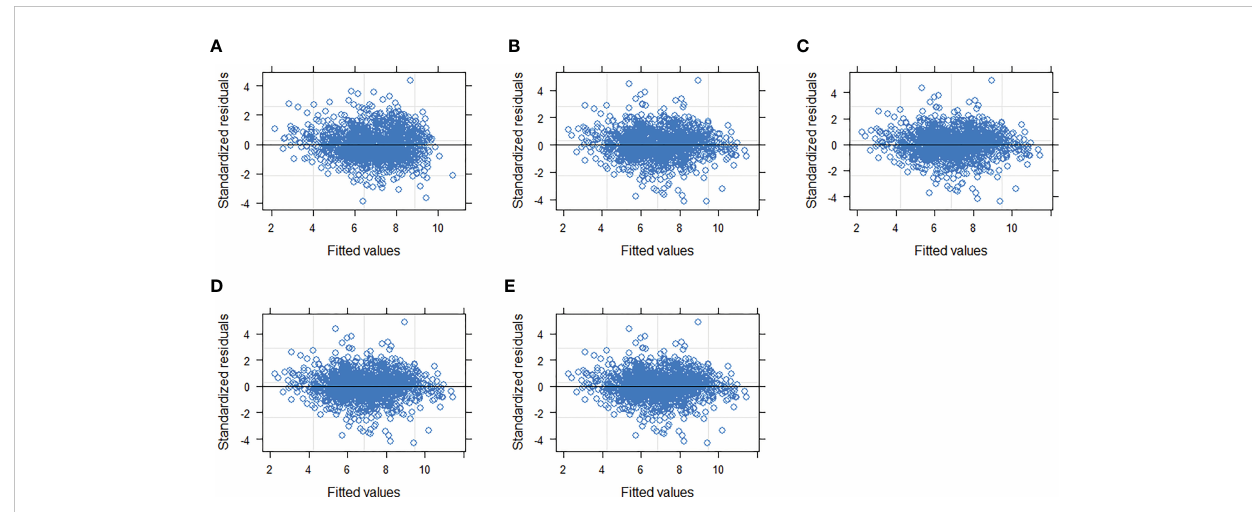
FIGURE 6 Residual distribution of the NLME HCB (Eq. 12) with and without using the variance functions. (A) OLS, (B) variance function not included, (C – E) different variance functions (Eqs. 6 – 8) included,